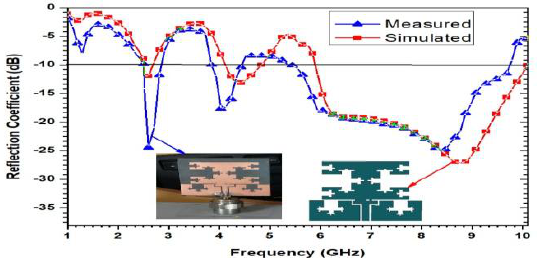
Figure 5: Measured and Simulated Reflection Coefficient of the proposed antenna